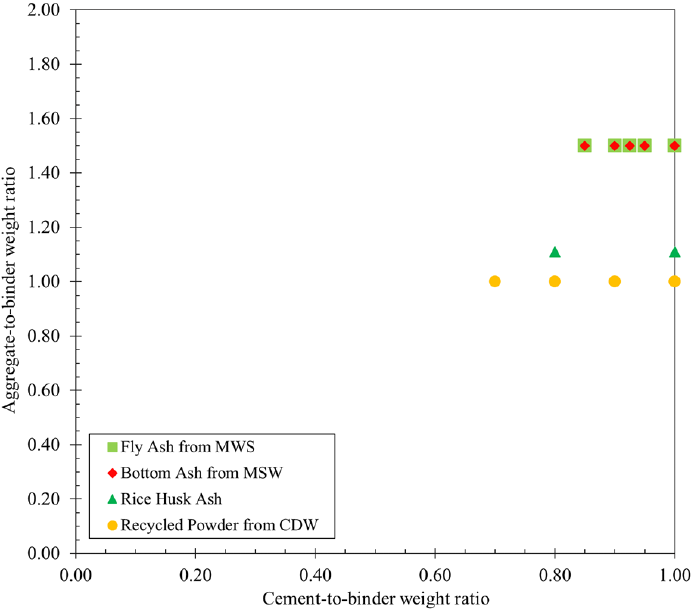
Figure 8. Cement-to-binder weight ratio and aggregate-to-binder weight ratio in 22 3DPCCmixtures incorporating unconventional SCM as cement replacement (data source: [60 – 64]).